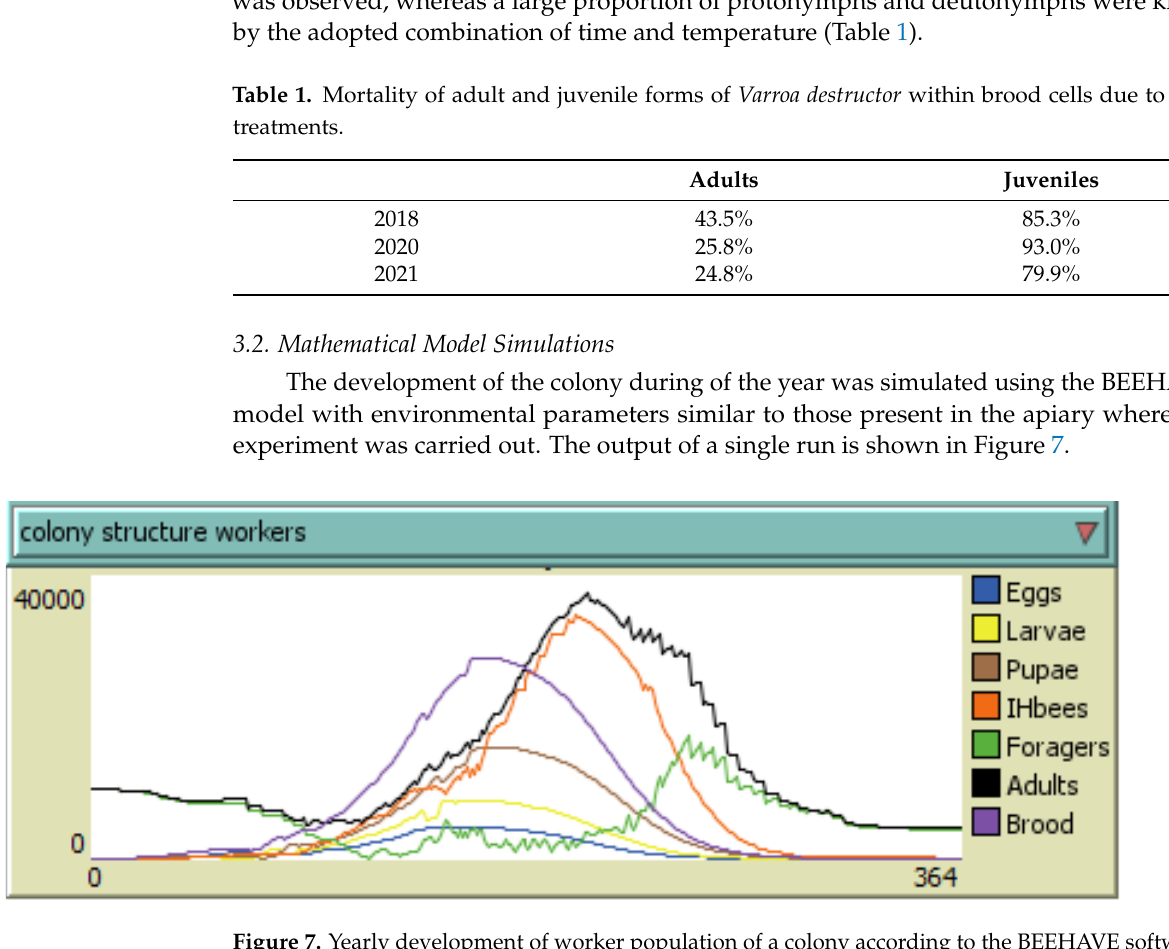
Figure 7. Yearly development of worker population of a colony according to the BEEHAVE software. The population dynamics of V. destructor were simulated under different control approaches and various re-infestation